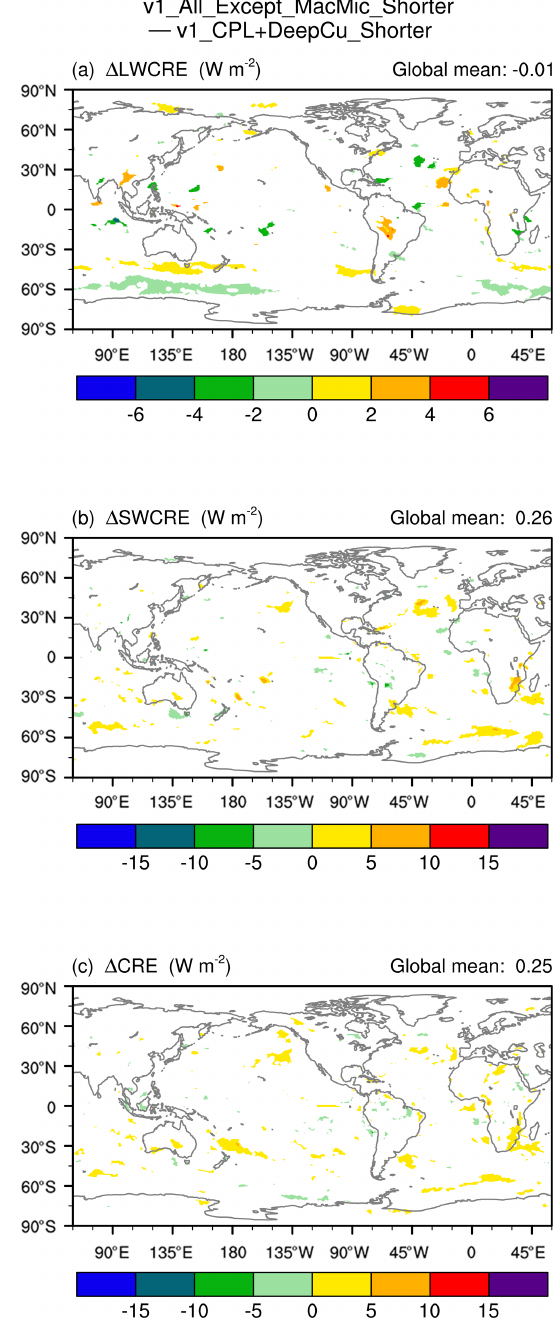
Figure 14. The 10-year mean CRE differences between simulations v1_All_Except_MacMic_Shorter (see the schematic in Fig. 7b) and v1_CPL + DeepCu_Shorter (see the schematic in Fig. 13), revealing the impact of shortened dynamics and radiation time steps. White indicates statistically insignificant differences. The simulation se- tups are summarized in Tables 1 and